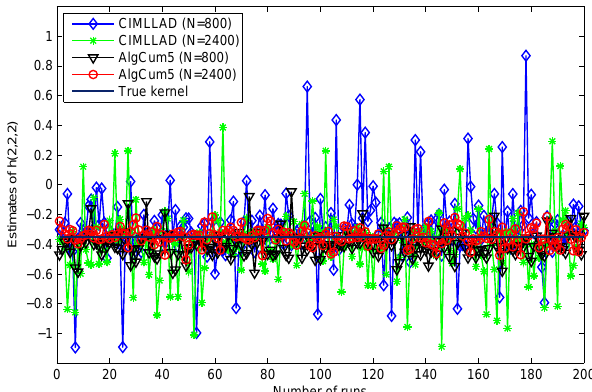
Figure 3. Estimated cubic kernel, h ( 2,2,2 ) = − 0.35, for system I.